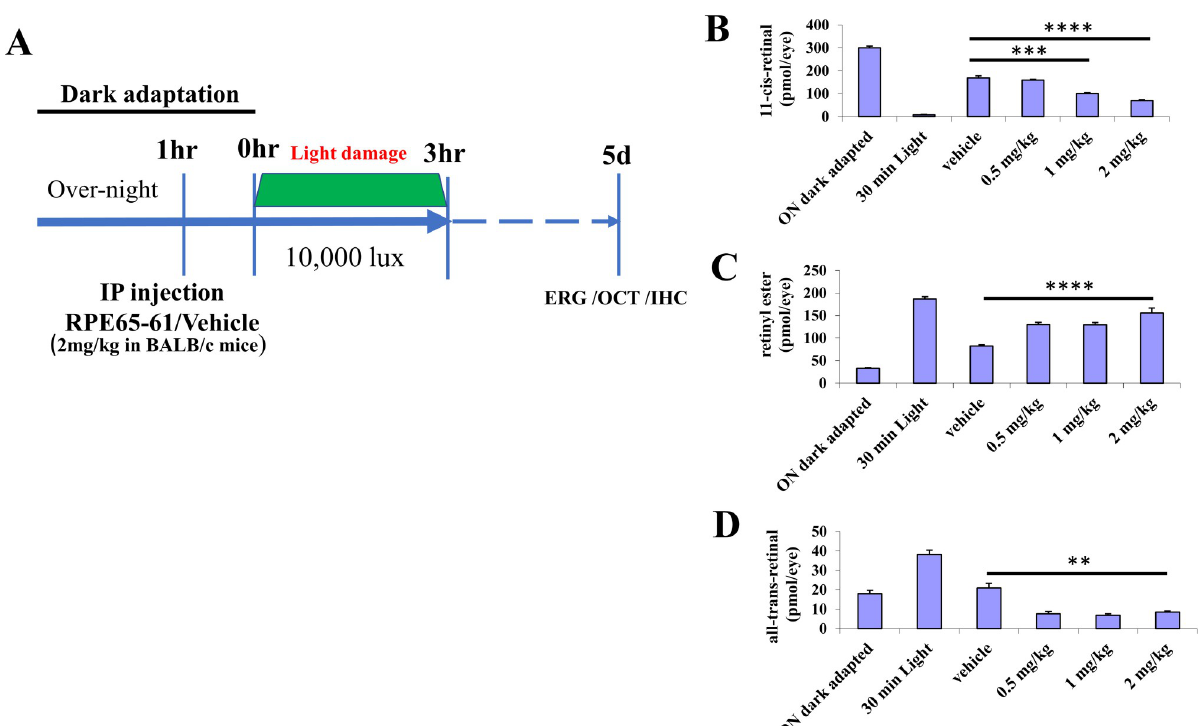
Fig 4. Systemic treatment by inhibitor ( ± )-RPE65-61 delays chromophore regeneration in BALB/cJ mice. (A) Schematic representation of the experimental design for the study of ( ± )- RPE65-61 retina protection against light damage in vivo. (B-D) Retinoids levels in the inhibitor treated mouse eyes during dark adaptation after the photobleach. Dark-adapted mice were injected with varying amounts of ( ± )- RPE65-61 , and subjected to light- adaptation under 5000 lx of fluorescent light for 30 min. The eyes were harvested for HPLC retinoid profiling after 30 min of dark-adaptation, to measure levels of (B) 11- cis -retinal, (C) retinyl ester, and (D) all- trans -retinal. Student’s t-test. �� P < 0.01, ��� < 0.001 and ���� < 0.0001. (Mean ± SEM, n =